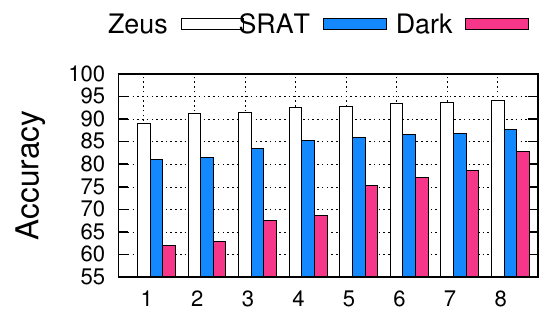
Figure 6. The accuracy of classifying various malware families with varying n . Table 4. Accuracy of classifying various families for different values of n when calculating the n -gram individual features.